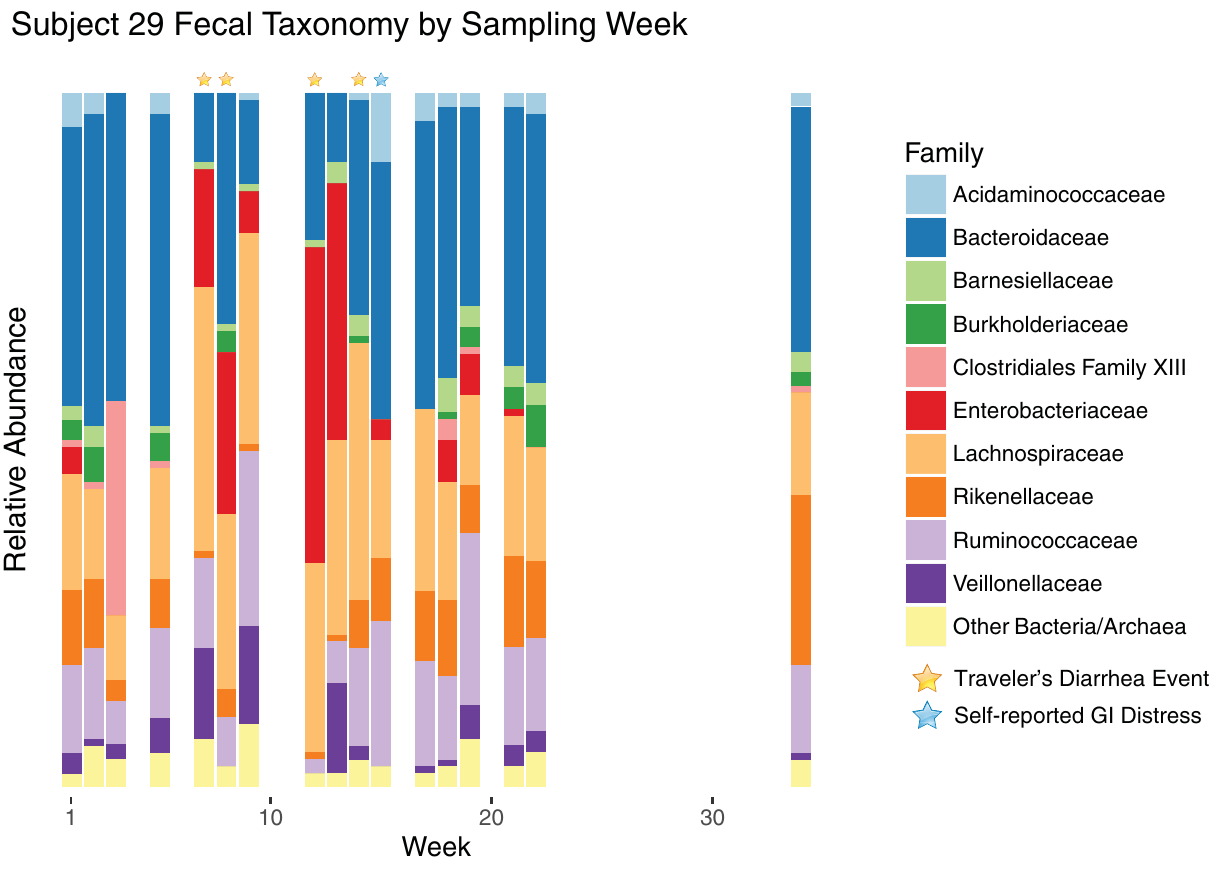
Fig 3. Family level taxa over time for Subject 29. Time series of family-level taxa for a subject experiencing multiple episodes of TD. Subject 29 is shown with taxa from the ten most abundant bacterial families for this subject, with the remaining bacteria and archaea collapsed into a single category.